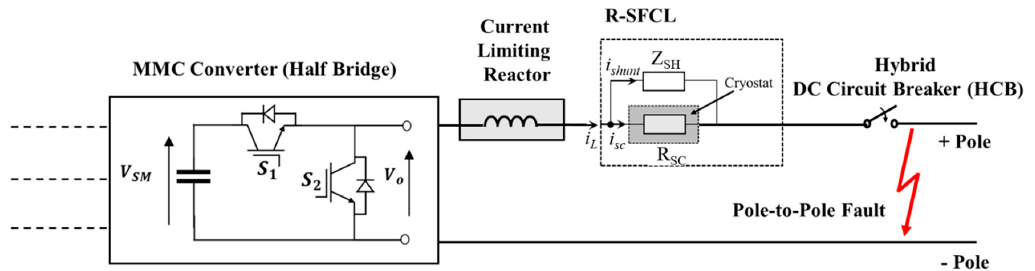
Figure 3. Case 1: Protection scheme composed of HB-MMC, R-SFCL and HCB.